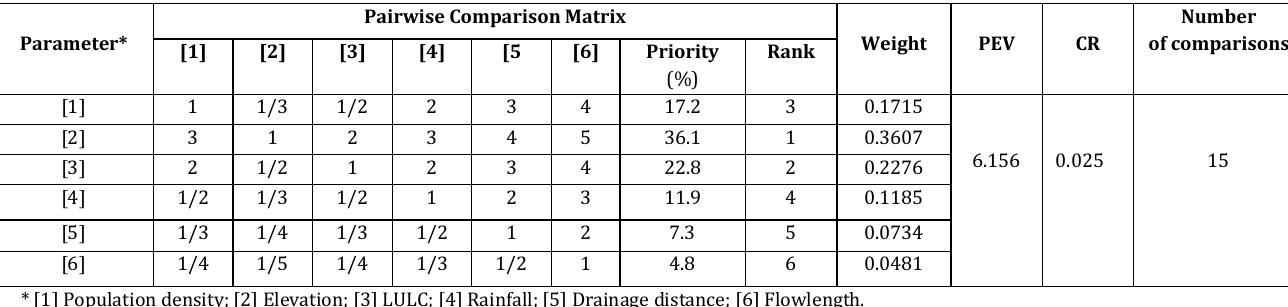
Table 4: AHP parameter values used in this study. Priority: numbers associated with the nodes of an AHP hierarchy; PEV: principal eigenvalue; CR: consistency ratio. Number of comparisons: pairwise comparisons with the other parameters and with itself.